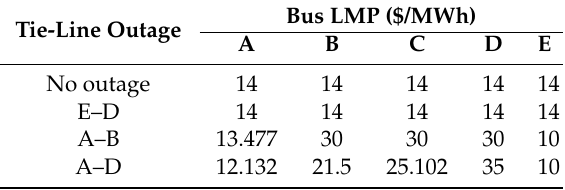
Table 3. Bus LMPs of PJM 5-bus system under different tie-line outages with 700 MW